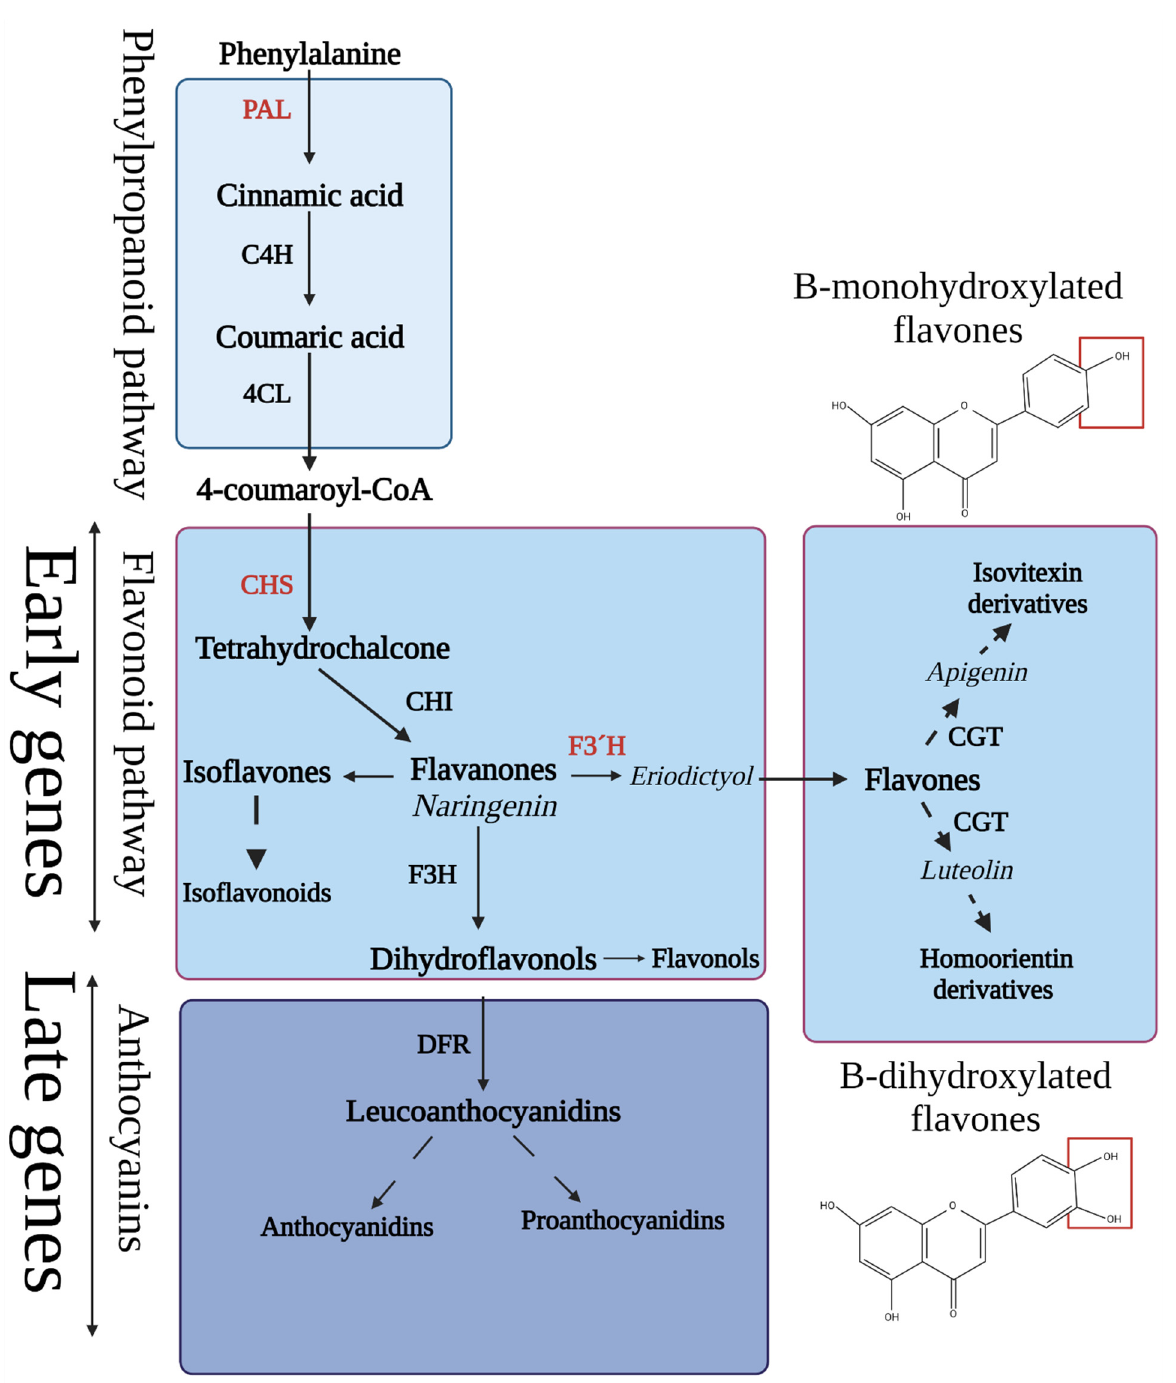
Figure 1. Simplified scheme of pathways responsible for phenolic compound biosynthesis with highlighted early and late gene groups encoding PheC-related enzymes. The expression of genes labeled in red was studied in this experiment. PAL (phenylalanine ammonia lyase; EC 4.3.1.24), C4H (cinnamate 4-hydroxylase; EC 1.14.13.11), 4CL (4-coumarate CoA-ligase; EC 6.2.1.12), CHS (chalcone synthase; EC 2.3.1.74), CHI (chalcone isomerase; EC 5.5.1.6), F3 ′ H (flavonoid 3 ′ -hydroxylase; EC 1.14.14.82), CGT (c-glucosyltransferase; EC 2.4.1.360), F3H (flavanone 3-hydroxylase; EC 1.14.11.9), and DFR (dihydroflavonol 4-reductase; EC 1.1.1.219). Typical structures of B-monohydroxylated (apigenin) and B-dihydroxylated (luteolin) flavones (derivatives of which are present in soluble form in barley leaves) are shown and their structural difference is marked red.